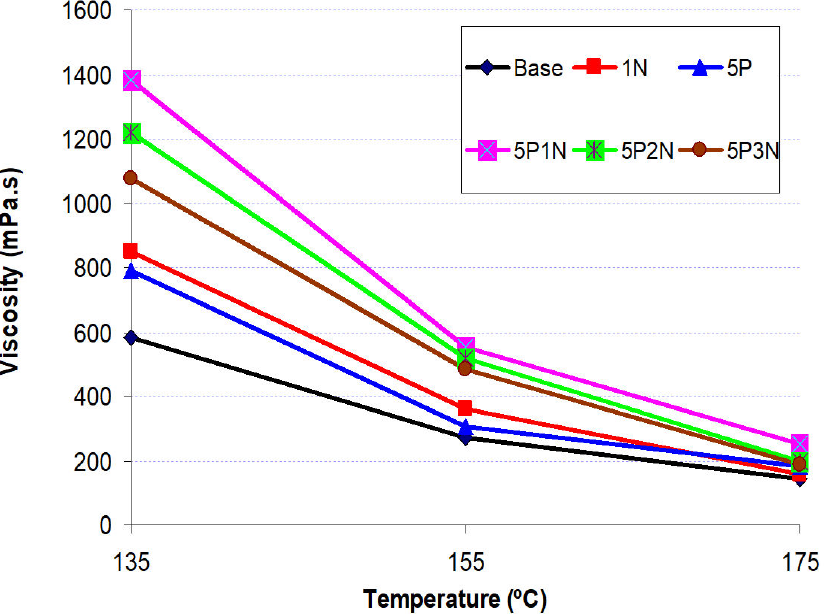
Figure 5. Viscosity of base asphalt, and five types of modified asphalt with different